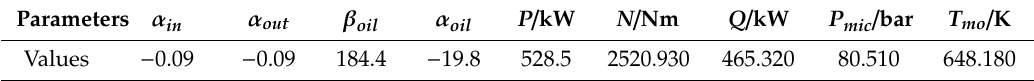
Table 12. Calculation results of diesel engine’s optimal state parameters.